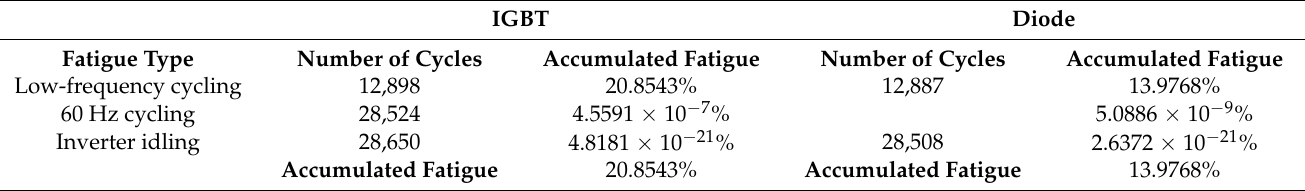
Table 15. Accumulated fatigue results from the two-year simulation with reduced thermal profile.